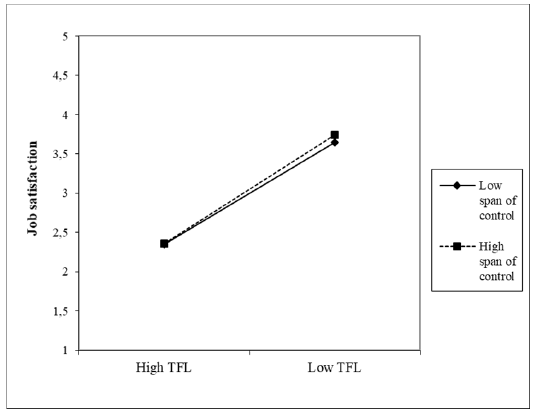
Figure 4. Moderating effect of the span of control on the CS–JS relationship.